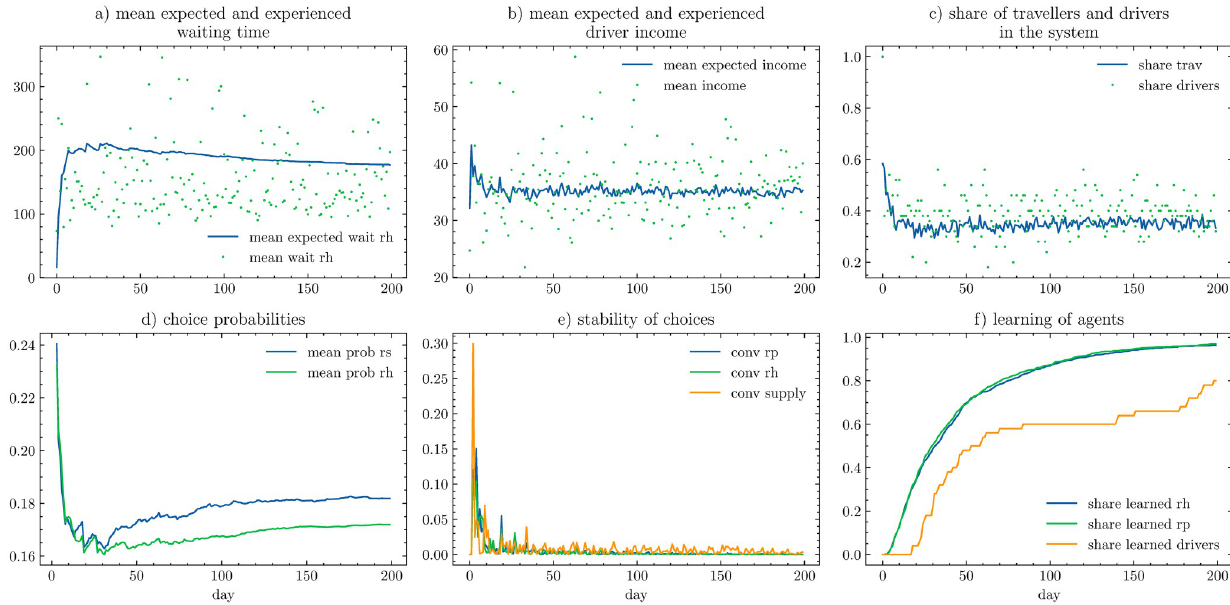
Fig 10. 200 days of supply and demand evolution for the case study experiment with 900 travellers and 50 drivers. Travellers expected waiting time (a) stabilises over consecutive days (blue line) despite the high day-to-day variability of actually experienced waiting times (green dots). Similarly for the drivers, whose mean expected incomes (b) remain stable around 35 € , with day-to-day variability (green dots) ranging from 27 to 50 € . The share of travellers in the system (c) remains stable around 37% (blue line) yet the number of drivers (green dots) may range between 10 and 30%. The initially high choice probabilities for MaaS modes (d) happened to be over-optimistic and quickly drop from 24% to 16%. Yet, as agents learn, the pooled alternative (blue— rs ) becomes more popular than private ride (green— rh ) stabilising around 18%. Agent day-to-day choice evolution stabilises and the variability stays within the 2% range already after ca. 40 days of evolution (e). After 100 days 90% of travellers have gained enough experience to learn the system and stabilise their choices (blue and green in the panel f). However, drivers learn slower with only 60% of them finishing the learning process after 100 days (orange on panel